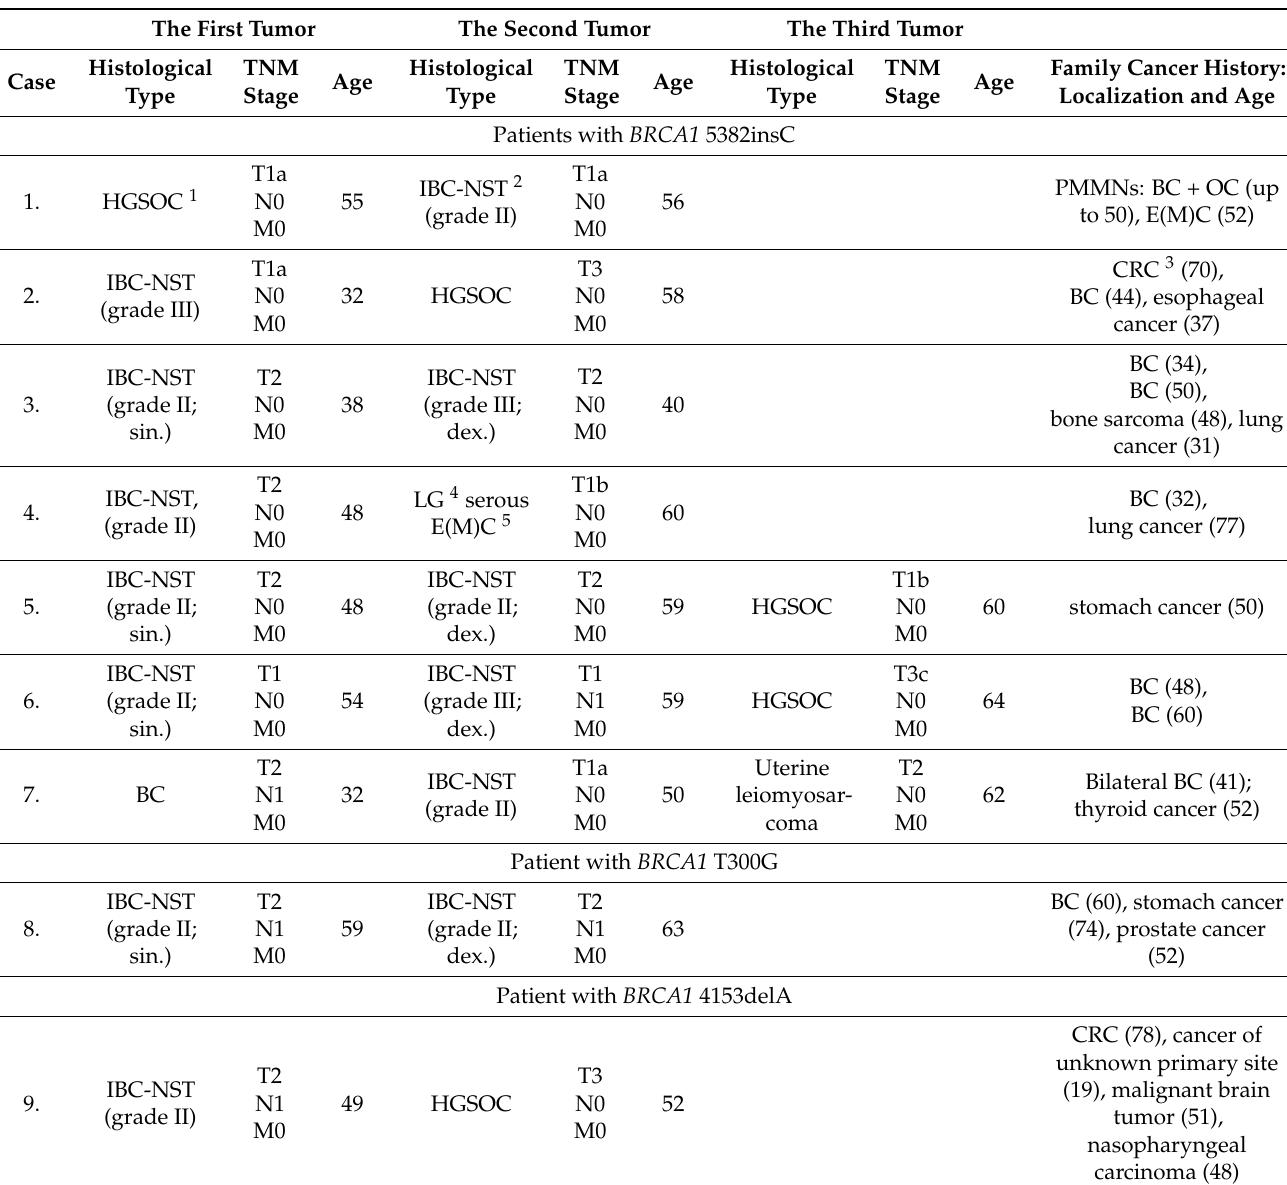
Table 1. Mutation carriers and their family